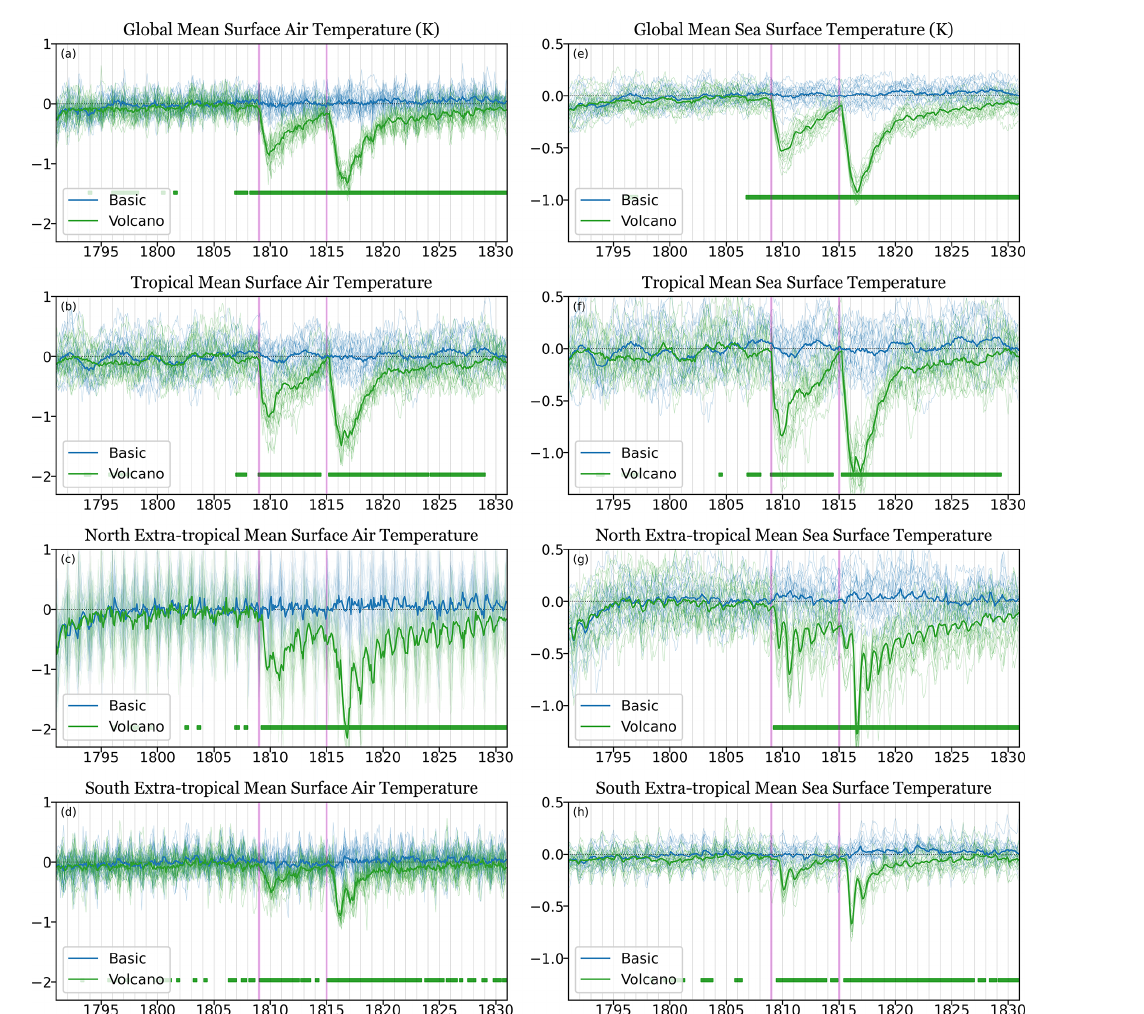
Figure 4. As in Fig. 2 but for the Volcano